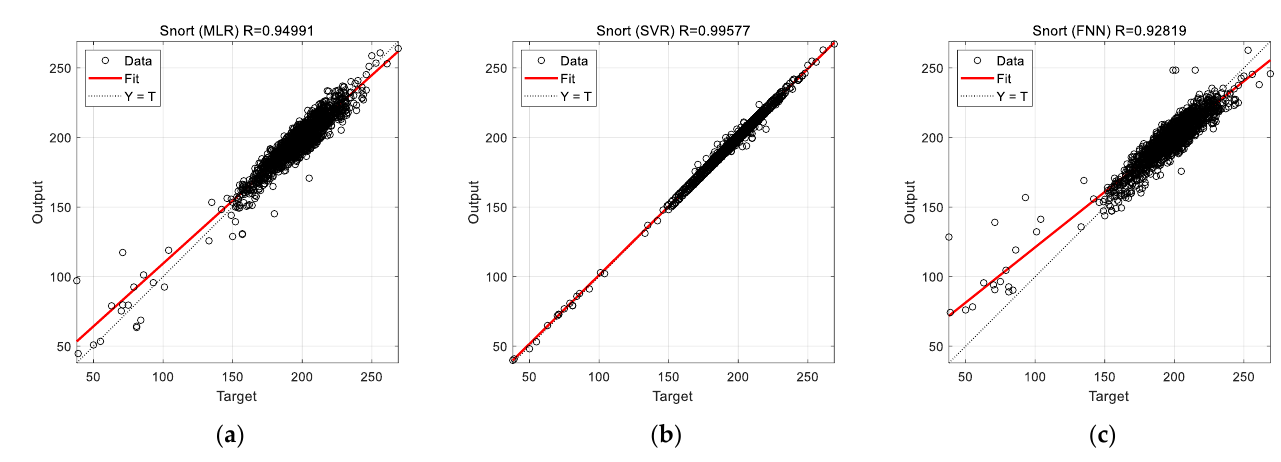
Figure 8. Open vSwitch regression plot: ( a ) MLR; ( b ) SVR; and ( c ) FNN.